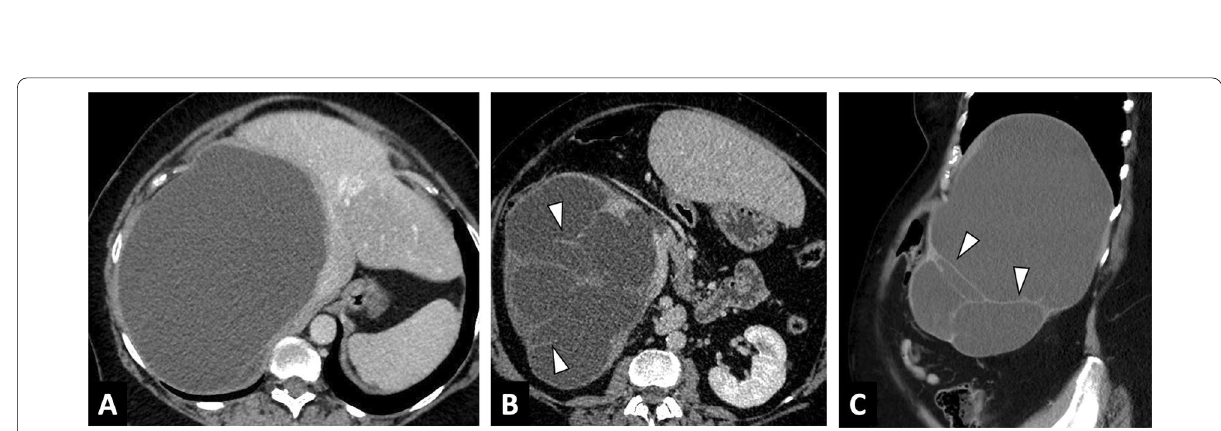
Fig. 15 Differential diagnosis of cystic echinococcosis lesion in a 64‑year‑old woman. A CT image in the axial plane at the portal phase showing a large right liver cyst. B Same examination, lower slices. Internal enhanced septa. C CT image in the sagittal plane at the portal phase showing internal enhanced septa ruled out a cystic echinococcosis lesion, confirming the diagnosis of biliary mucinous